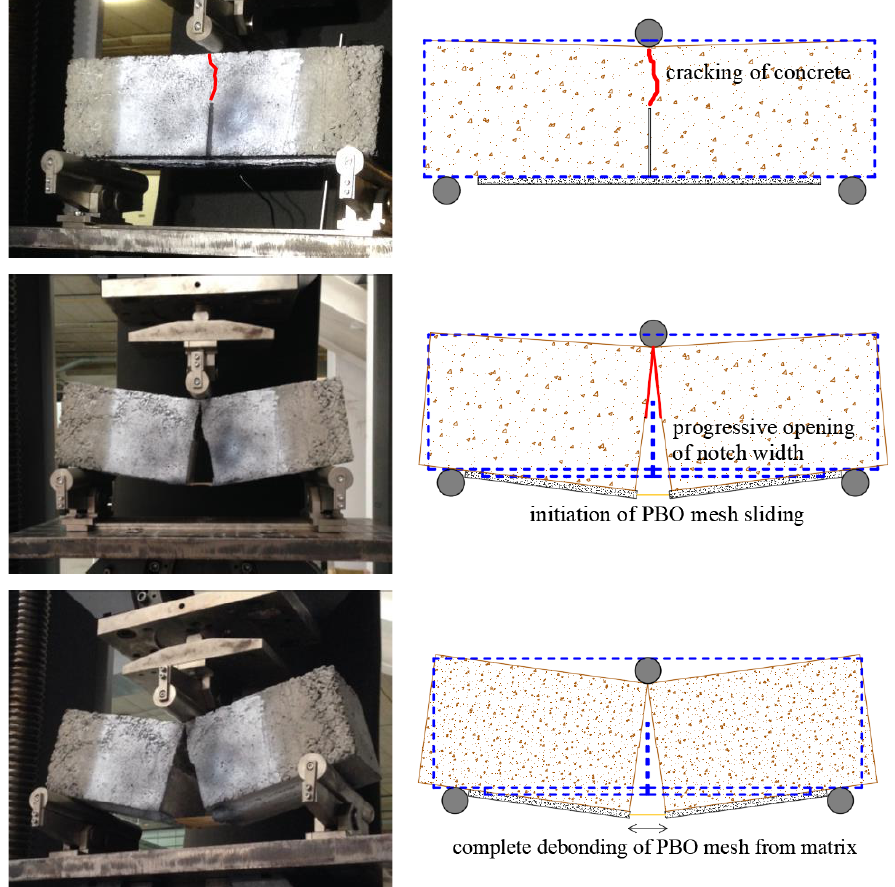
Figure 10. Results of the tests in terms of failure modes.